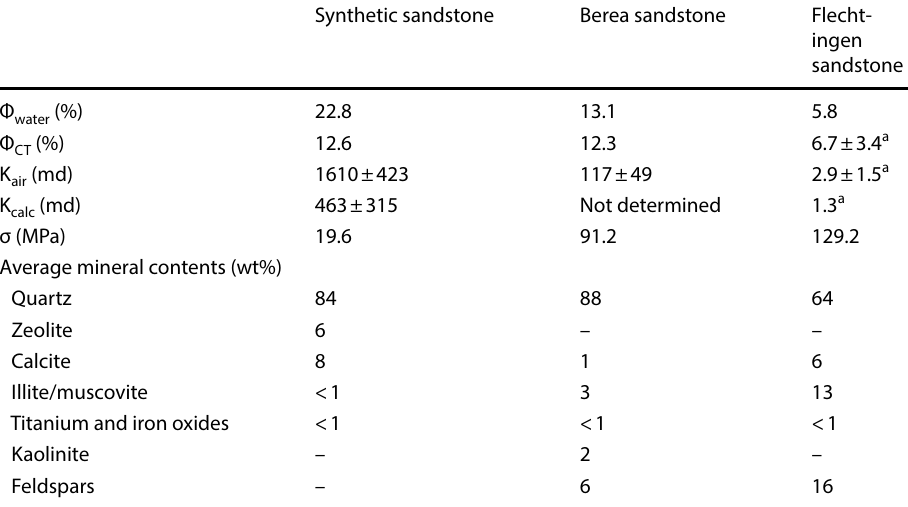
Table 1 Petrophysical properties and mineralogical composition of the synthetic sandstone plug